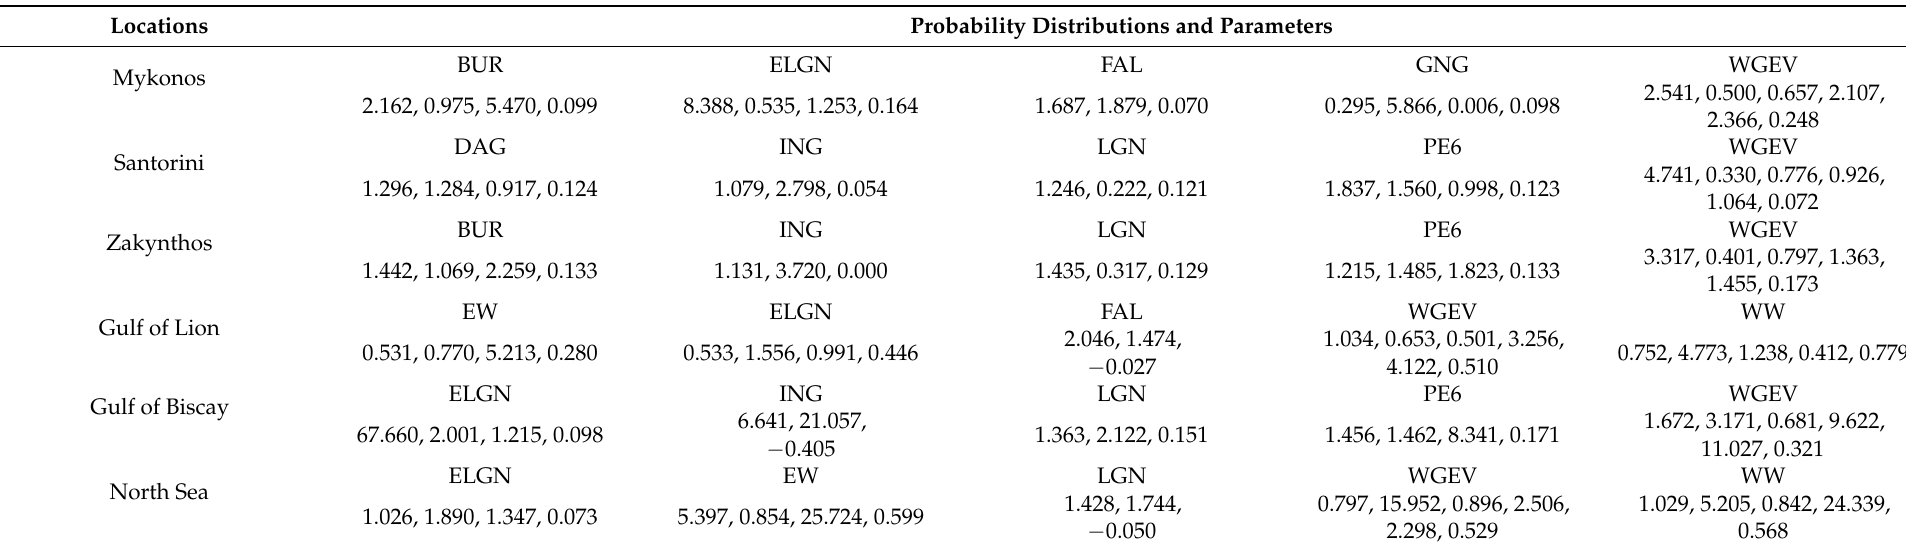
Table 5. Parameters of the five best-fit univariate conventional and mixture distributions for the examined